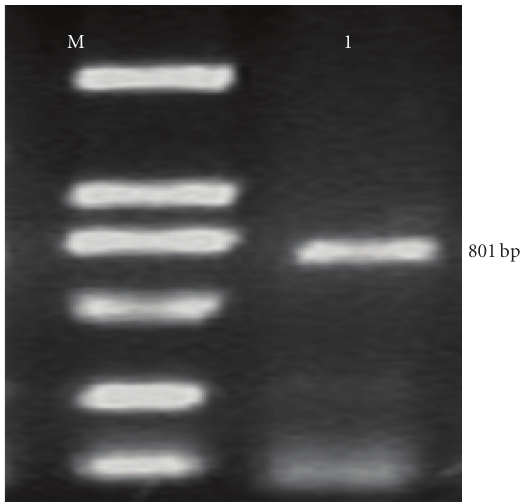
Figure 2: Restriction enzyme analysis of pPICZ α A NS1 recombi- nant plasmid with XhoI and NotI in the Forward and backward primers, respectively; lanes 2 and 3: vector-3.2 kb and insert gene 801bp, lane1: 1 kb DNA ladder marker (Fermentas,